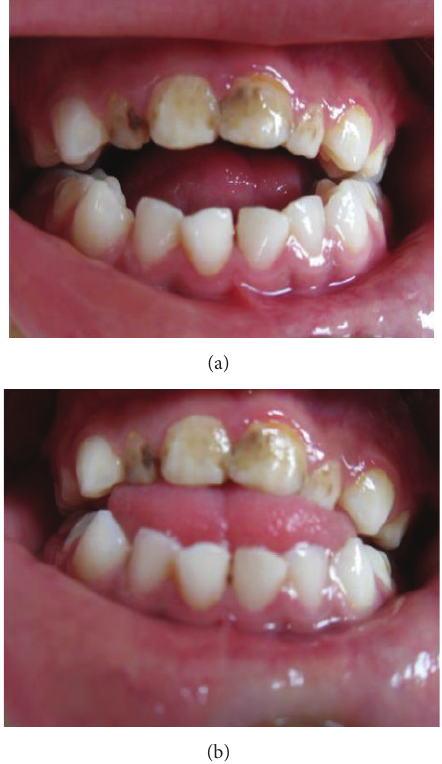
Figure 2: Oral findings related to PKS: oral breathing, anterior open bite, tongue thrust, mandibular prognathism, and